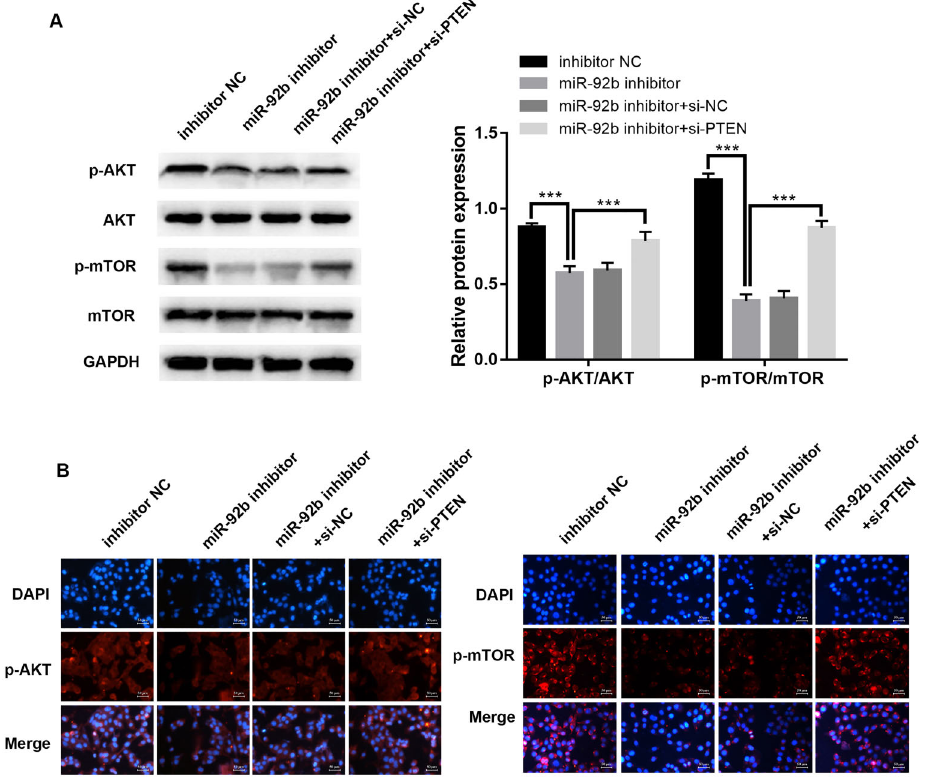
Figure 5. Knockdown of miR-92b suppresses PI3K/AKT/mTOR signaling pathways in HepG2/SOR cells and down-regulation of PTEN reverses the effect. A , Western blot analysis of p-mTOR, mTOR, p-AKT, and AKT. B , Representative immuno fl uorescence photomicrograph of p-AKTand p-mTOR (red). Nuclei were stained with DAPI (blue). Scale bar: 50 m m. Data are reported as means ± SD. ***P o 0.001 (ANOVA). NC: negative